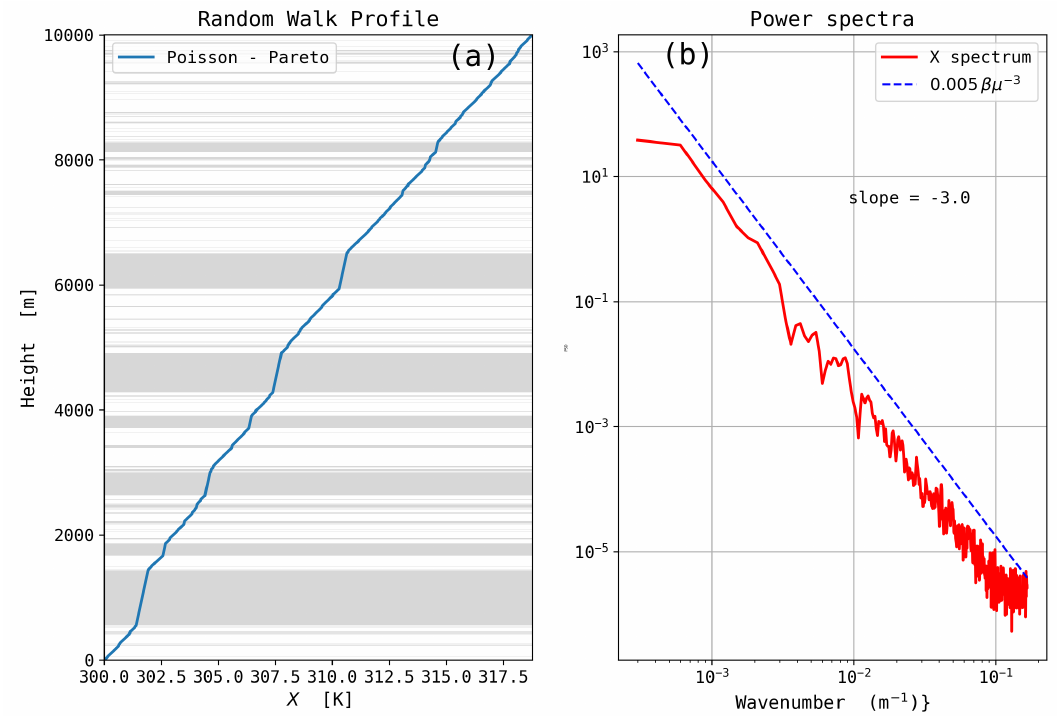
Figure A2. ( a ) PT profile built from the increments shown in Figure A1 (Poisson/Pareto model). ( b ) The